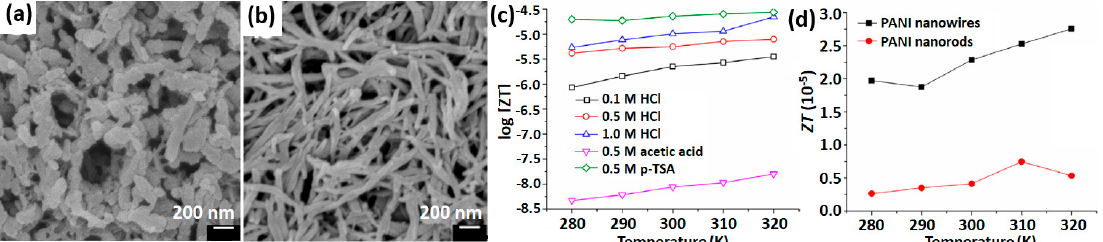
Figure 9. SEM images of ( a ) PANI nanorods prepared in an ice bath; ( b ) PANI nanowires prepared at room temperature. ( c ) The temperature (T) dependence of figure-of-merit ZT of different acid doped PANI nanowires. ( d ) The temperature (T) dependence of figure-of-merit ZT of p-TSA doped PANI nanowires and nanorods. Readapted with permission from Elsevier B.V. [80] .